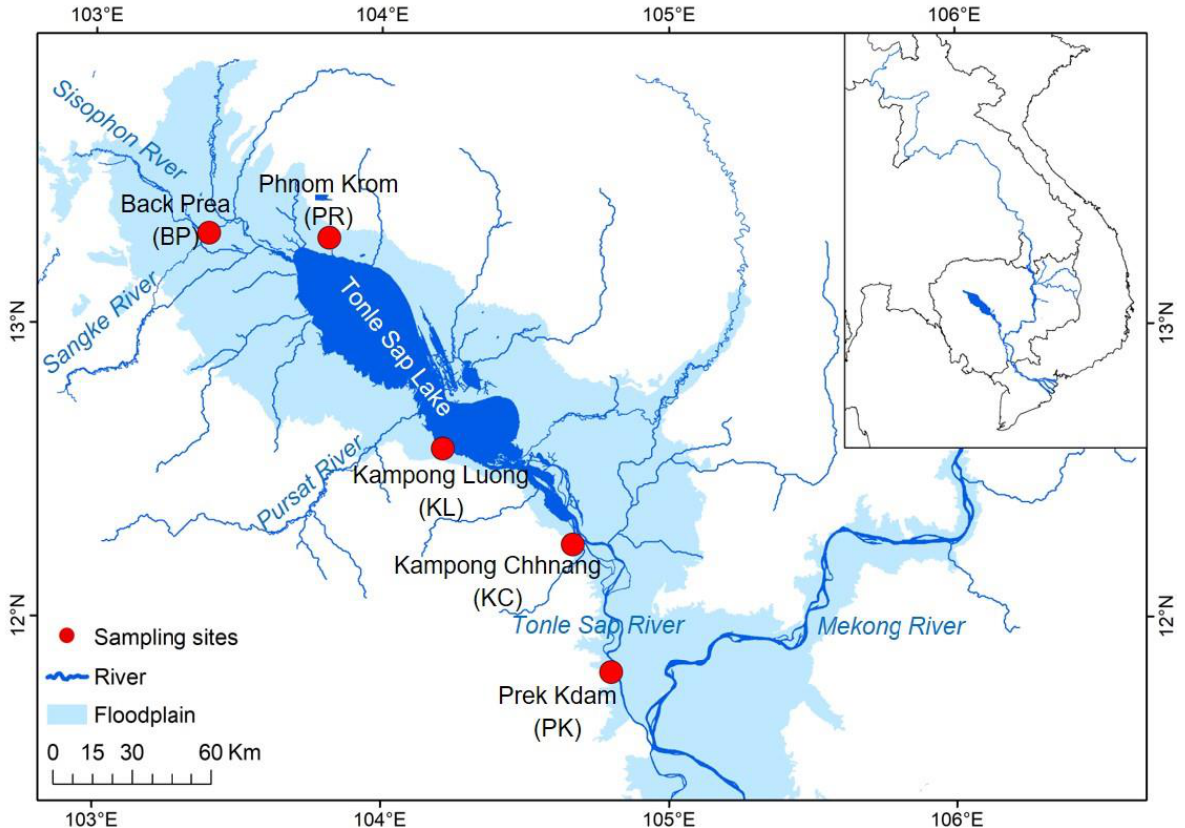
Figure 1. Sampling sites in the Tonle Sap Ecosystem.